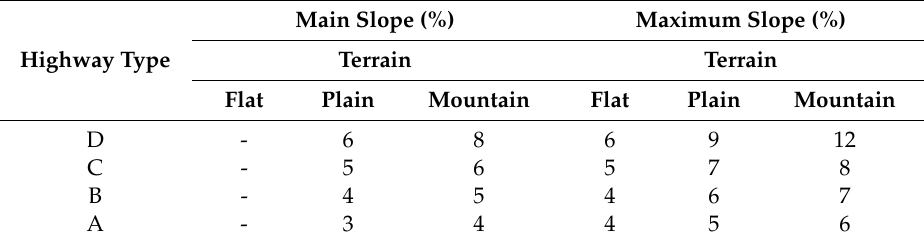
Table 3. Governing and maximum slopes by type of